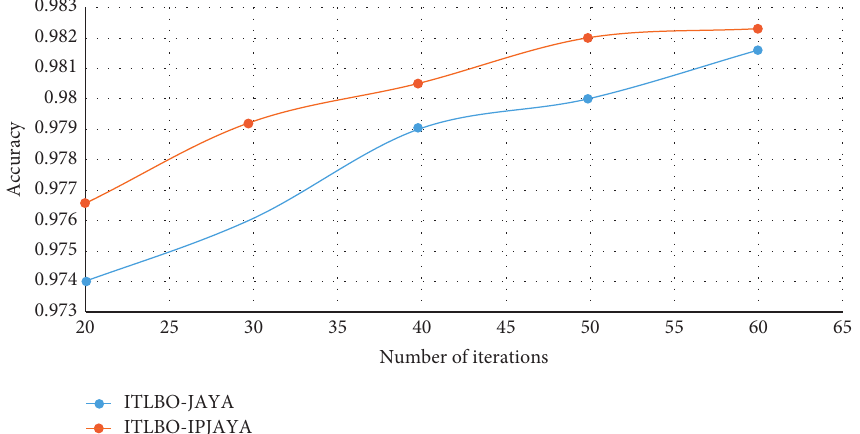
Figure 13: Accuracy comparison based on the number of iterations for the NSL-KDD dataset.